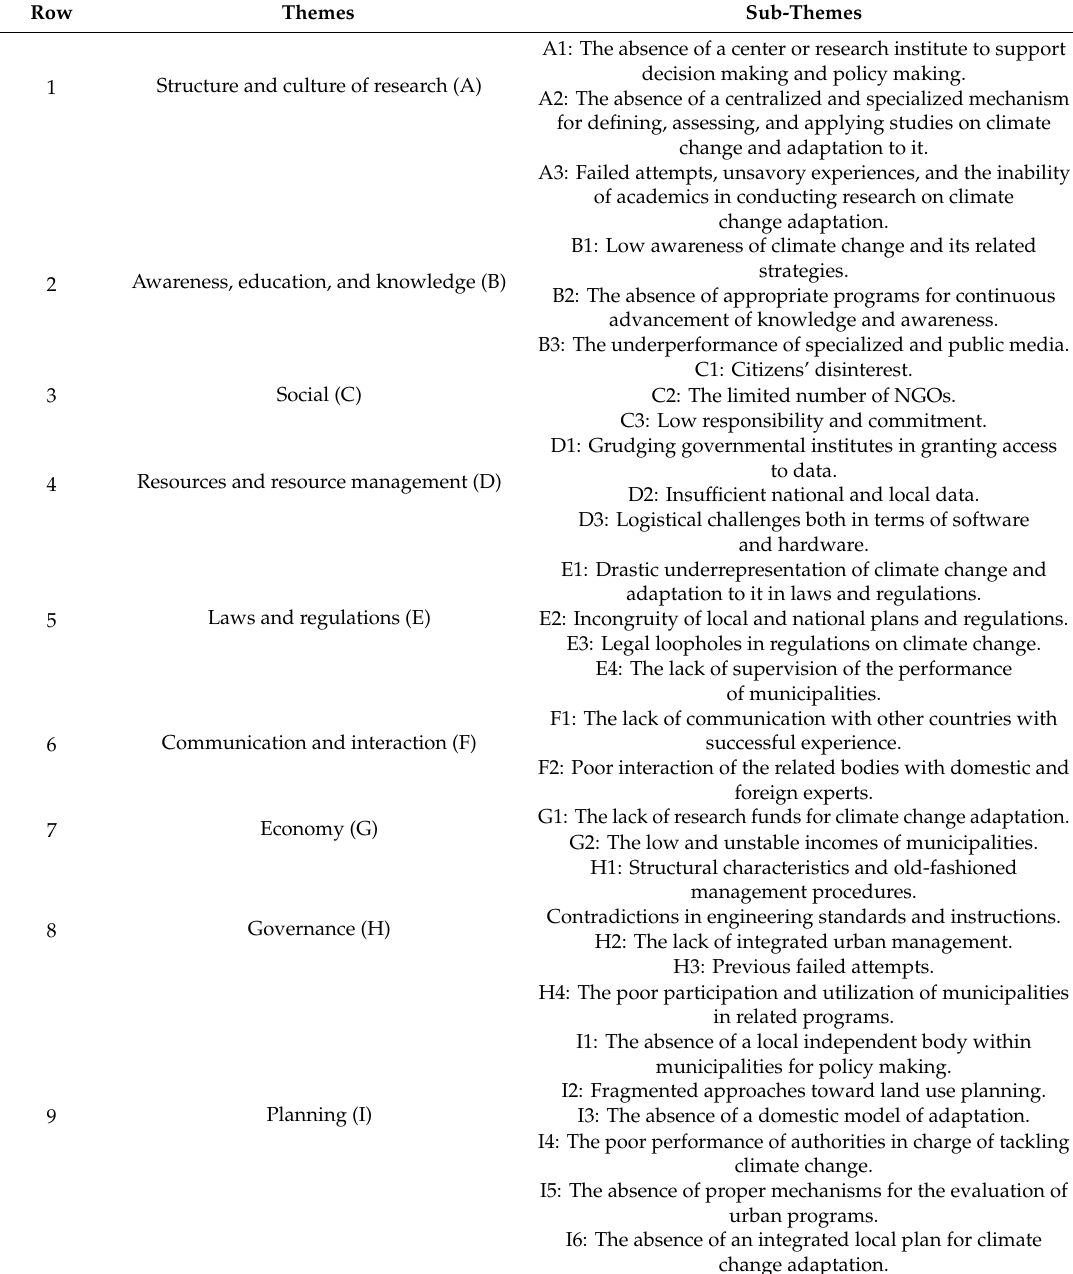
Table 1. Themes and sub-themes identified through focus group discussions (FGDs) as barriers to climate change adaptation